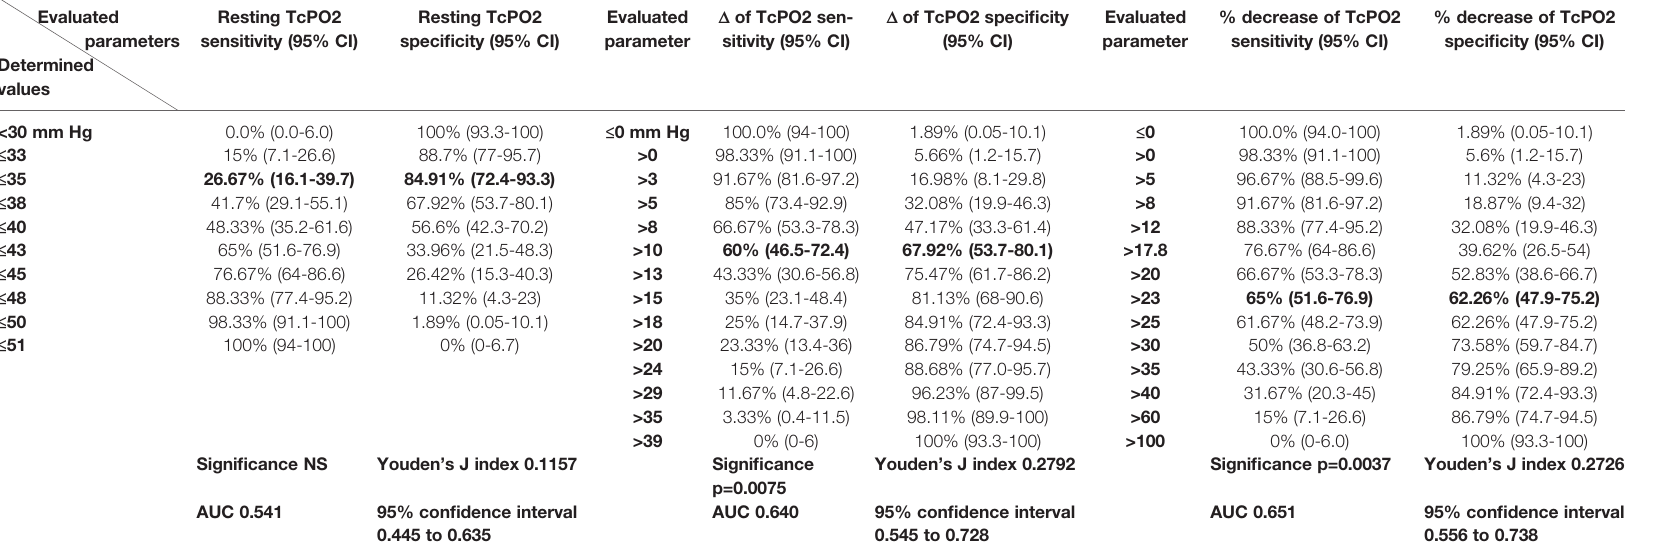
TABLE 5 | Sensitivity and speci fi city of microvascular assessment and TcPO2 parameters in relation to monophasic arterial fl ow supplying the relevant angiosome. Evaluated